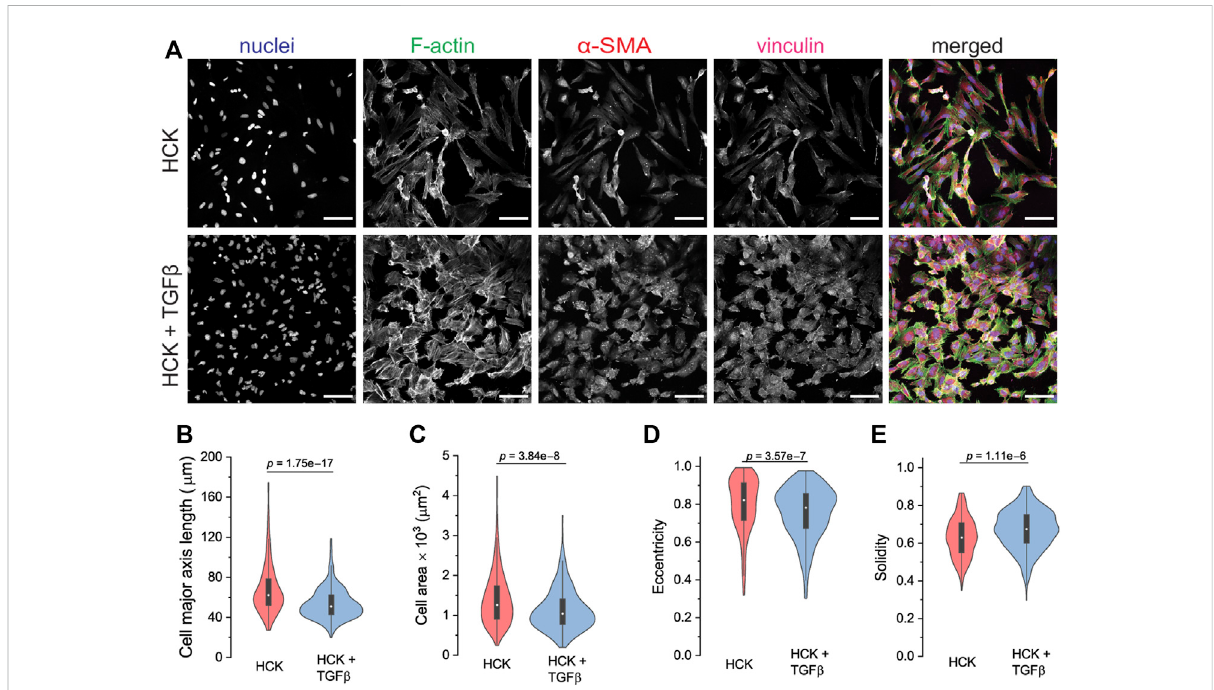
FIGURE 3 Cell phenotype and morphological analysis of HCK and HCK + TGF β cells. (A) Immuno fl uorescence staining of HCK and HCK + TGF β cells, showing the fi broblastandmyo fi broblast phenotypes, respectively. Cellswerestained for nuclei (Dapi, blue), F-actin(phalloidin, green), α -SMA(red), and vinculin (magenta). Scale bar: 100 µm. (B – E) Cell morphological quanti fi cation of (B) major axis length, (C) cell area, (D) eccentricity, and (E) solidity of both HCK and HCK + TGF β cells. n = 247 HCK cells and 512 HCK + TGF β